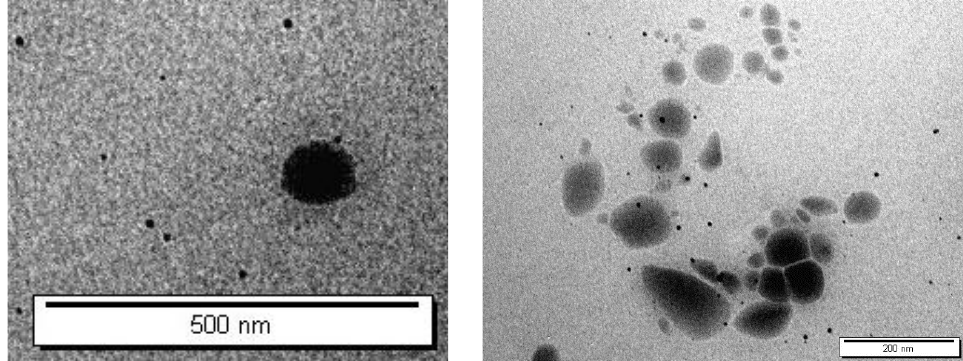
Figure 3. Transmission electron microscopy (TEM) micrographs of ALS-loaded niosomes (F4).